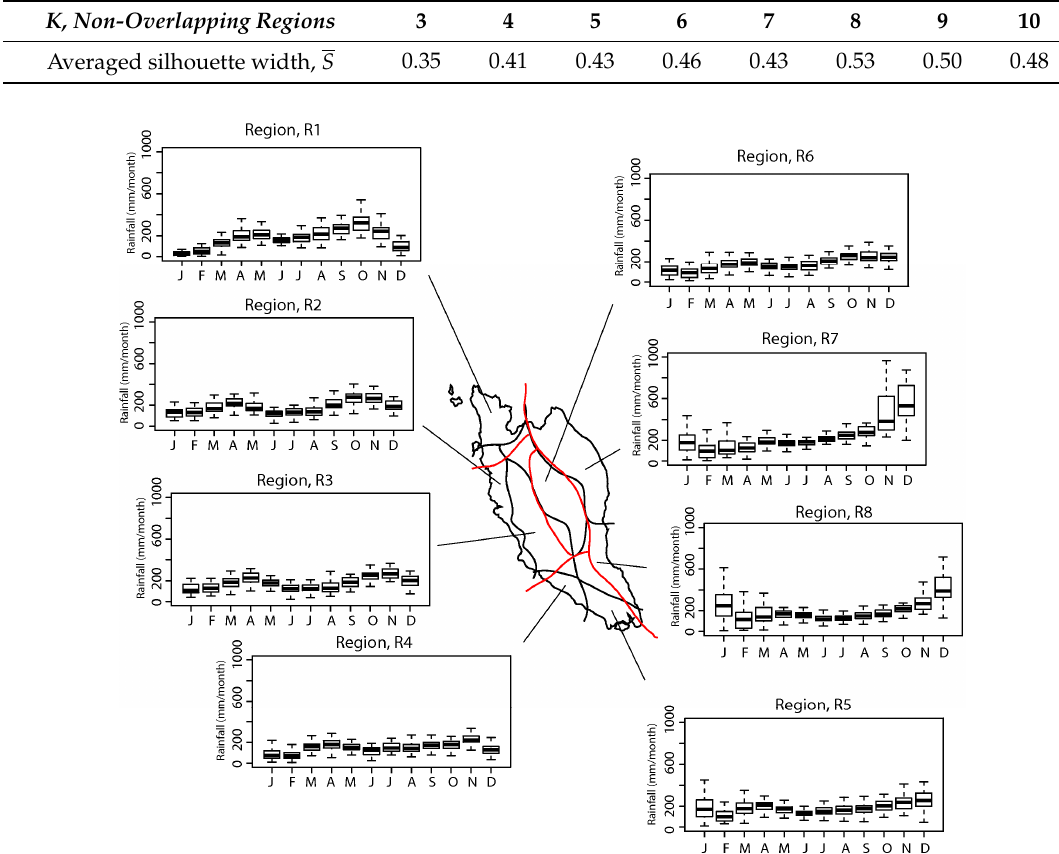
Table 1. Averaged silhouette width, S indicates better grouping if closer to one.